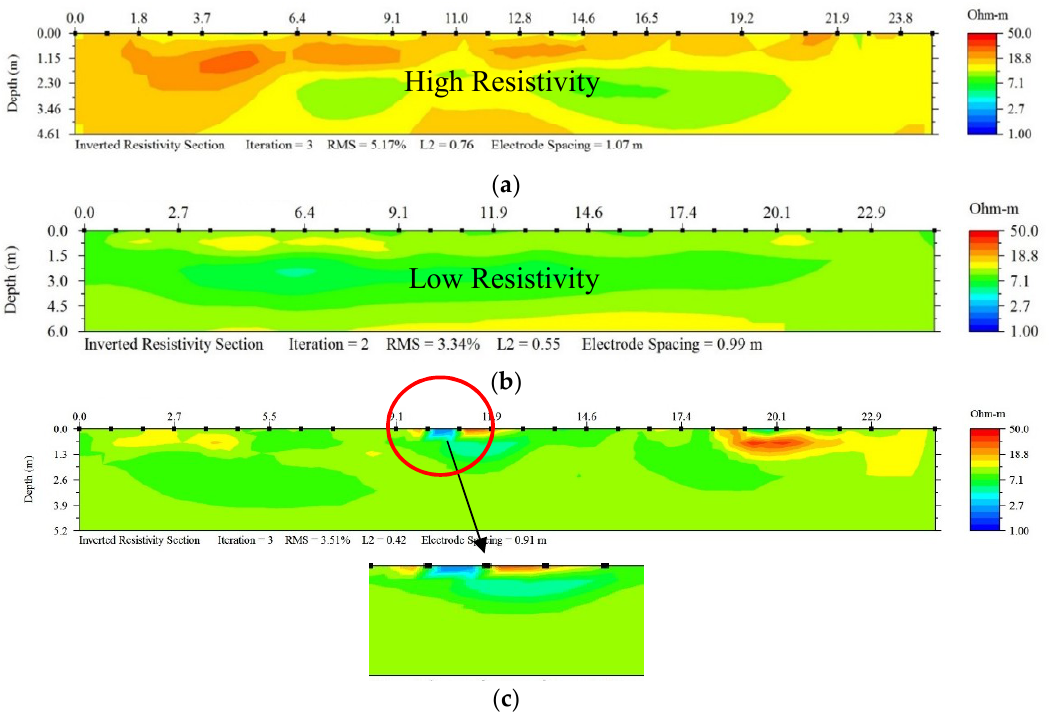
Figure 4. Resistivity variation in typical ( a ) dry period, ( b ) wet period, and ( c ) moisture intrusion through edge after rainfall.